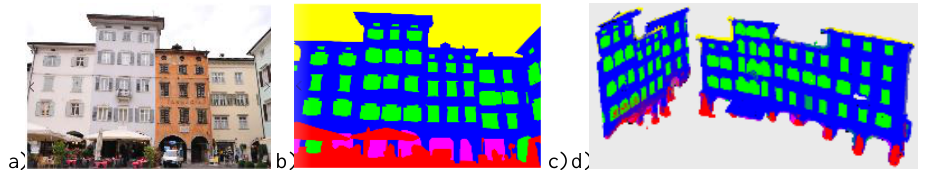
Figure 1: Boosting photogrammetric 3D reconstruction with semantic information: an input image (a), its corresponding automatic labelling in 4 classes (b) and the semantic 3D data (c) image network for 3D reconstruction (d). Semantic aids also the various photogrammetric steps, from tie point extraction to dense image